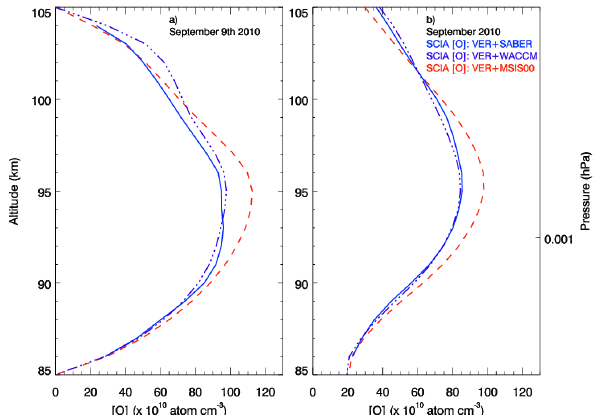
Figure 11. Sample daily (a) and monthly (b) averaged atomic oxy- gen concentration profiles ([O quench ] – blue solid, [O quench ] – SABER WACCM4 violet dash-dotted, [O quench ] – red dashed) according to the ex- MSIS00 tended cubic equation by Gobbi et al. (1992) and Khomich et al. (2008) for different sources of background atmospheric profiles and for the 20–25 ◦ N latitude